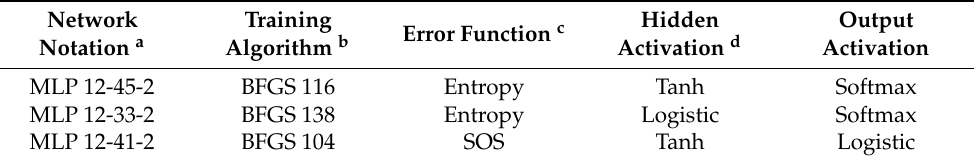
Table 2. Parameters characterizing the different MLP networks that were employed to build the mtc-QSAR-EL model.